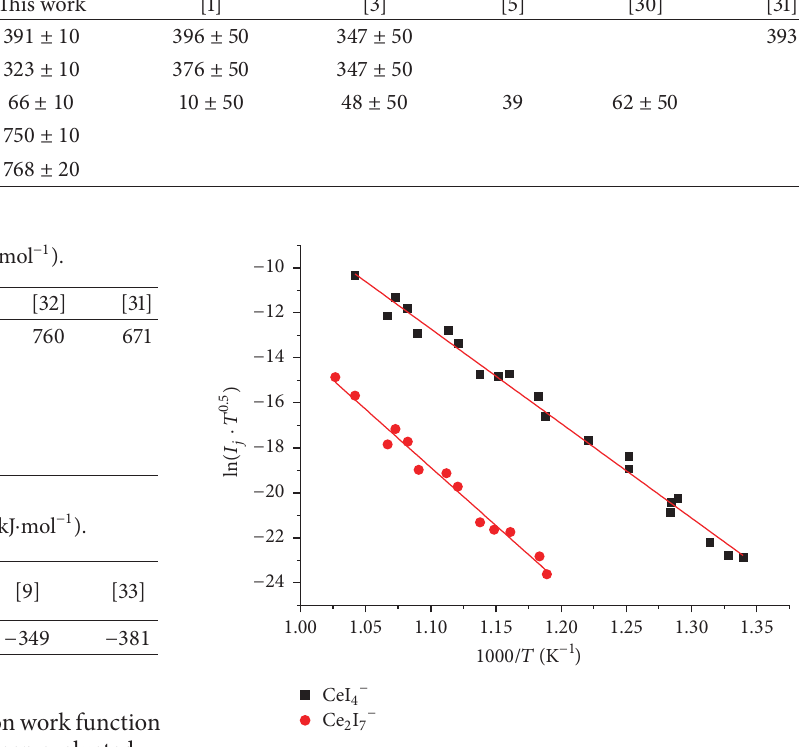
Figure 7: Temperature dependencies of CeI 4− and Ce 2 I 7− ion